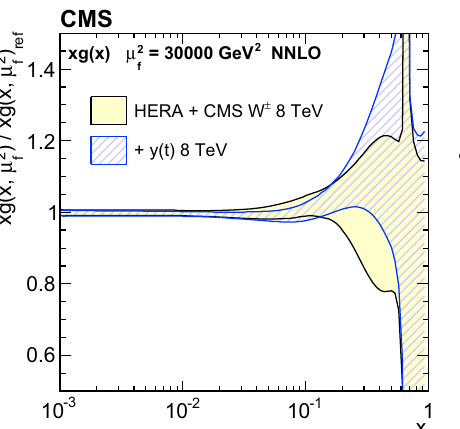
Fig. 19 The gluon distribution ( left ) and its fractional total uncertainty = 30 , 000GeV 2 , as obtained in the PDF fit at NNLO using ( right ) at μ 2 f the DIS and W ± boson charge asymmetry data only, as well as y ( t ) cross sections. The distributions shown in the left panel are normalized